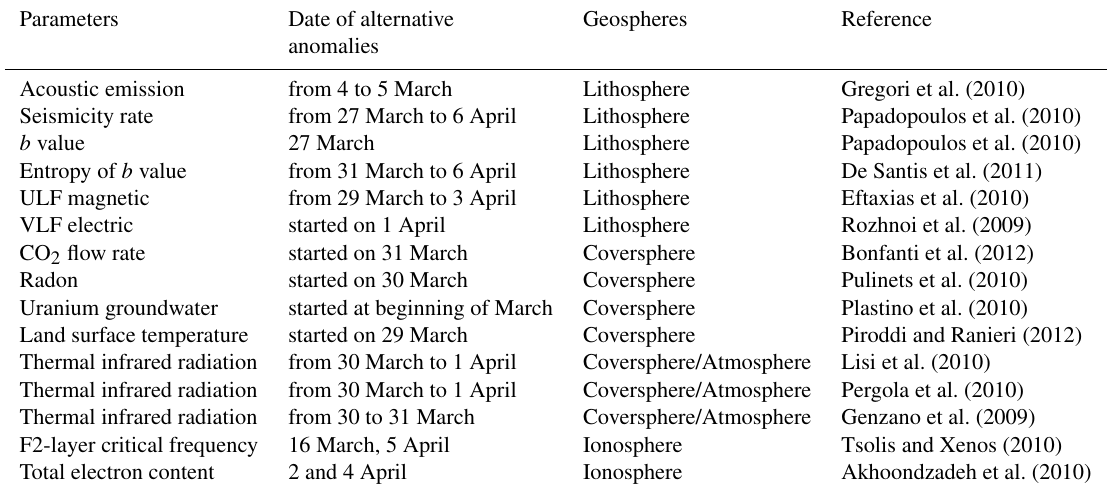
Table 1. Reported multiple-parameter anomalies associated with the M w 6.3 2009 L’Aquila